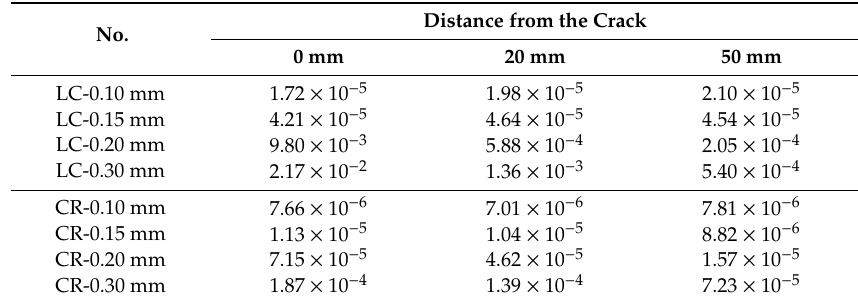
Table 3. Apparent chloride di ff usion coe ffi cients in di ff erent concrete samples with transverse cracks (m 2 / s).